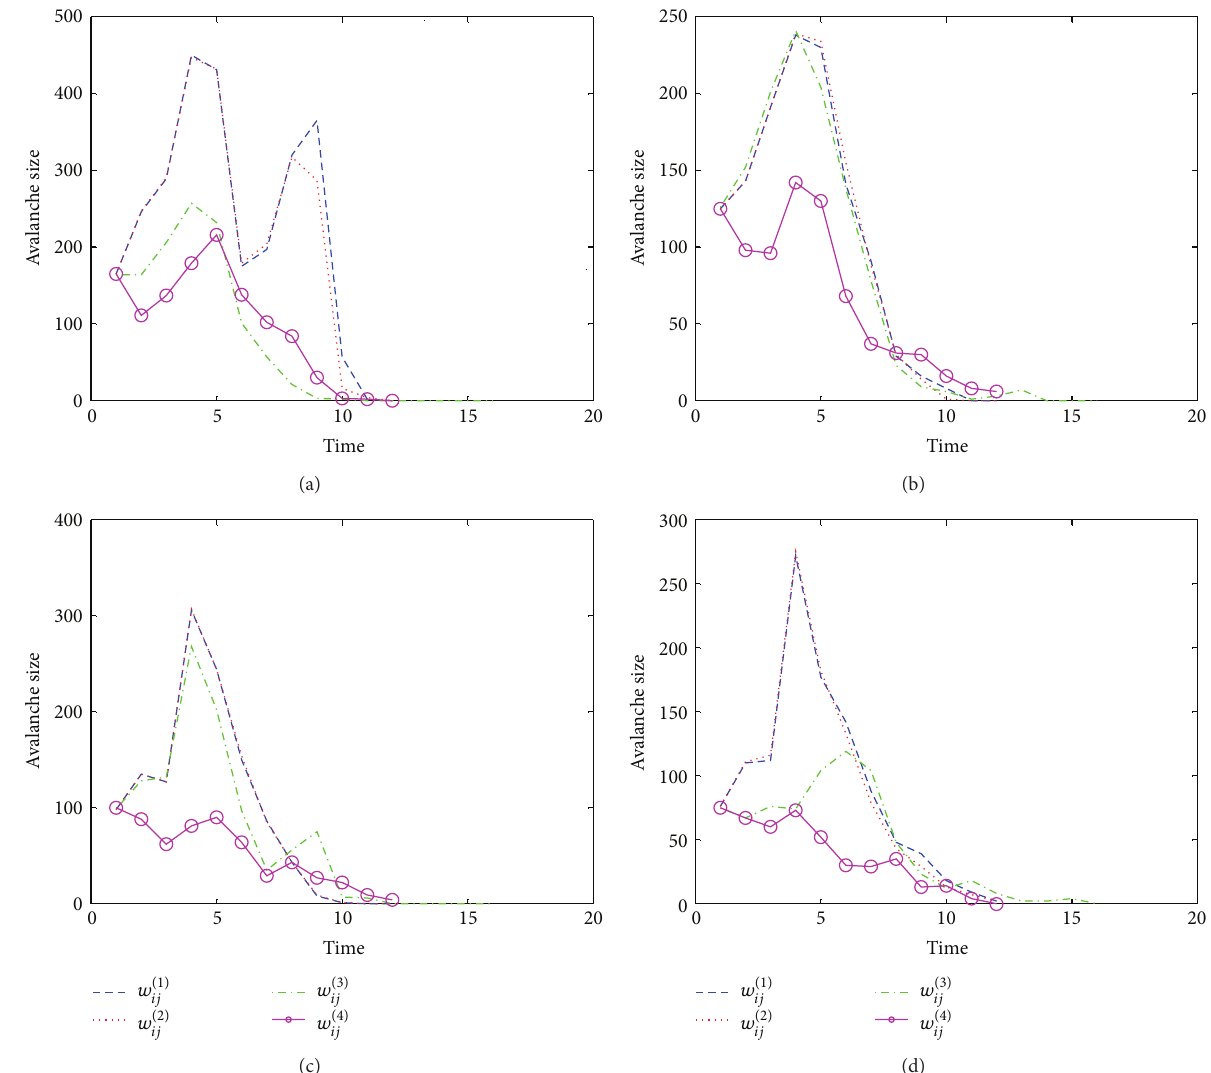
(𝑡) in each time step 𝑡 as a function of 𝑡 for (a) 𝛼 = 0.02 , (b) ae